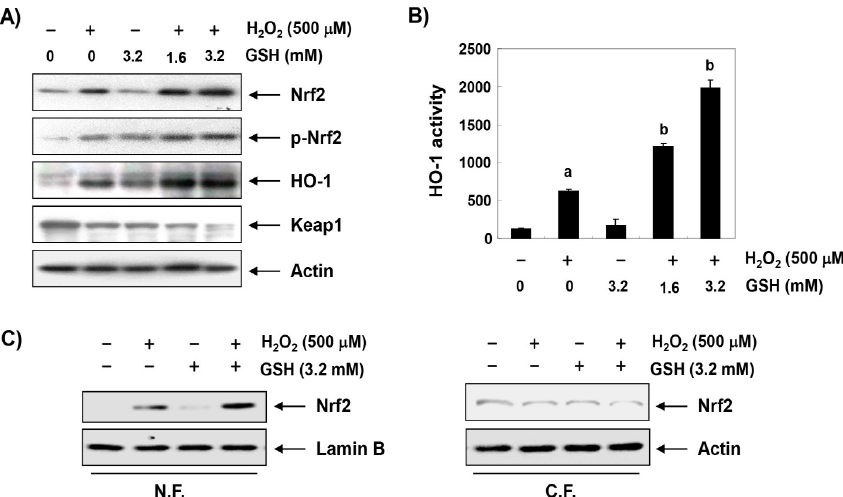
Figure 3. Effects of glutathione on the expression of Nrf2 and HO-1 in H 2 O 2 -treated RAW 264.7 cells. RAW 264.7 cells were pretreated with the indicated concentrations of glutathione for 1 h and then stimulated with or without 500 μM H 2 O 2 for 1 h. ( A ) Western blot analyses were performed with the indicated antibodies. The proteins were visualized using an enhanced chemiluminescence (ECL) detection system. Actin was used as an internal control. ( B ) The nuclear and cytosolic proteins were prepared and followed by Western blotting using the indicated antibodies. Lamin B and actin were used as internal controls. N.F., nuclear fraction; C.F., cytosolic fraction. ( C ) The HO-1 activities of cells grown under the same conditions were determined based on the bilirubin formation. The data were shown as the mean ± SD obtained from three independent experiments ( a p < 0.05 compared with the control group; b p < 0.05 compared with the H 2 O 2 -treated group).